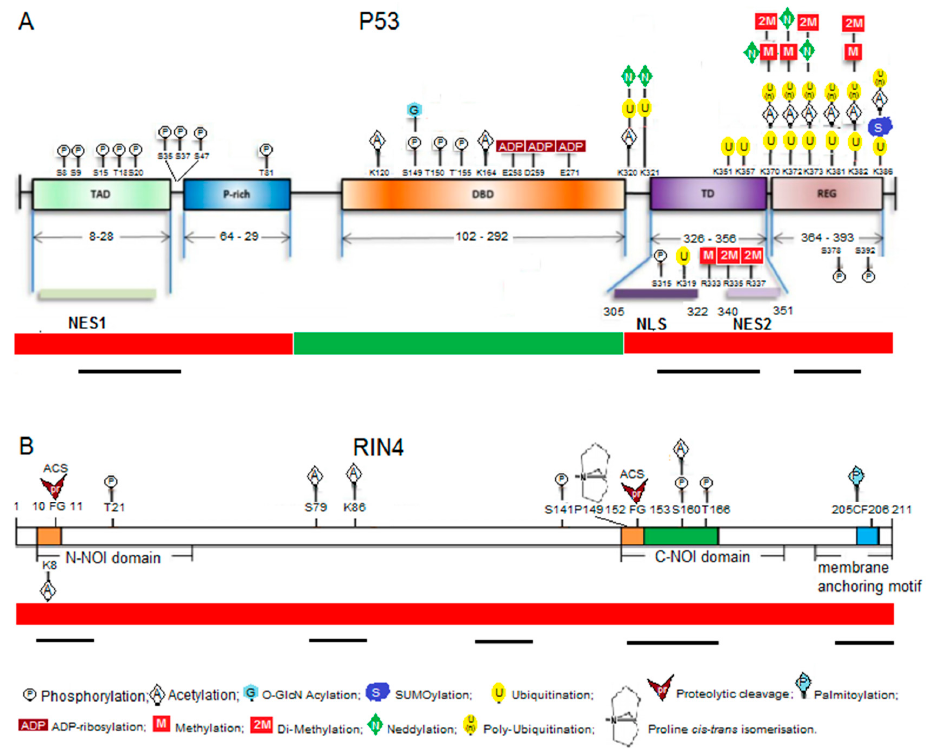
Figure 1. Multiple PTMs cluster in the Molecular Recognition Features within the disordered regions in p53 ( A ) and RIN4 ( B ). Consensus disordered regions are indicated by the red bar at the bottom while ordered regions are indicated by the green bar, putative MoRFs within the disordered regions are indicated by black bars as determined by Uversky (2016; p. 53, [23]) or Sun et al. (2014; RIN4, [32]) by application of disorder prediction programs. PTMs for p53 are a modified form of those identified by Gu and Zhu (2012) [24]. TAD: Transactivation domain; P-rich: proline-rich domain; DBD: DNA binding domain; TD: tetramerization domain; REG: C-terminal regulatory domain; NES1/2: N-terminal